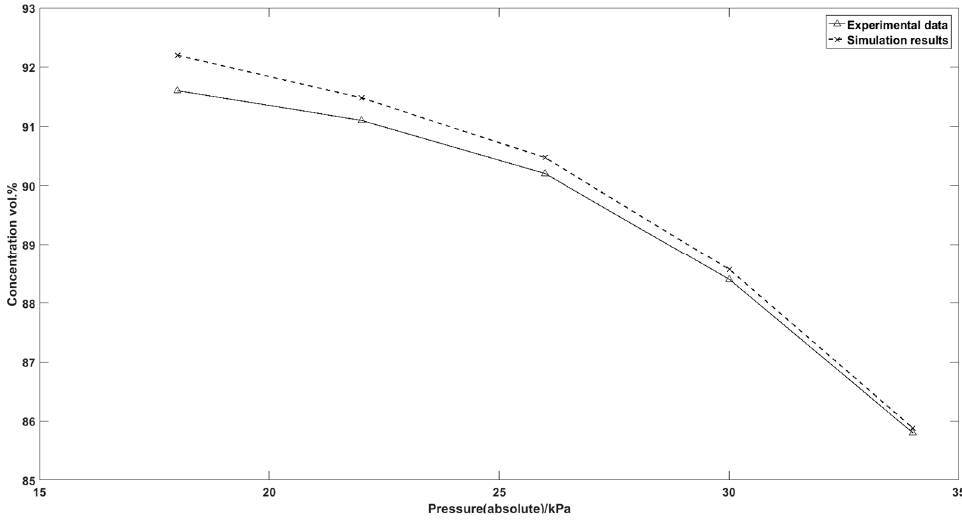
Figure 18. Output oxygen concentration peak from different vacuum swing range to 1.79 bar gauge pressure.